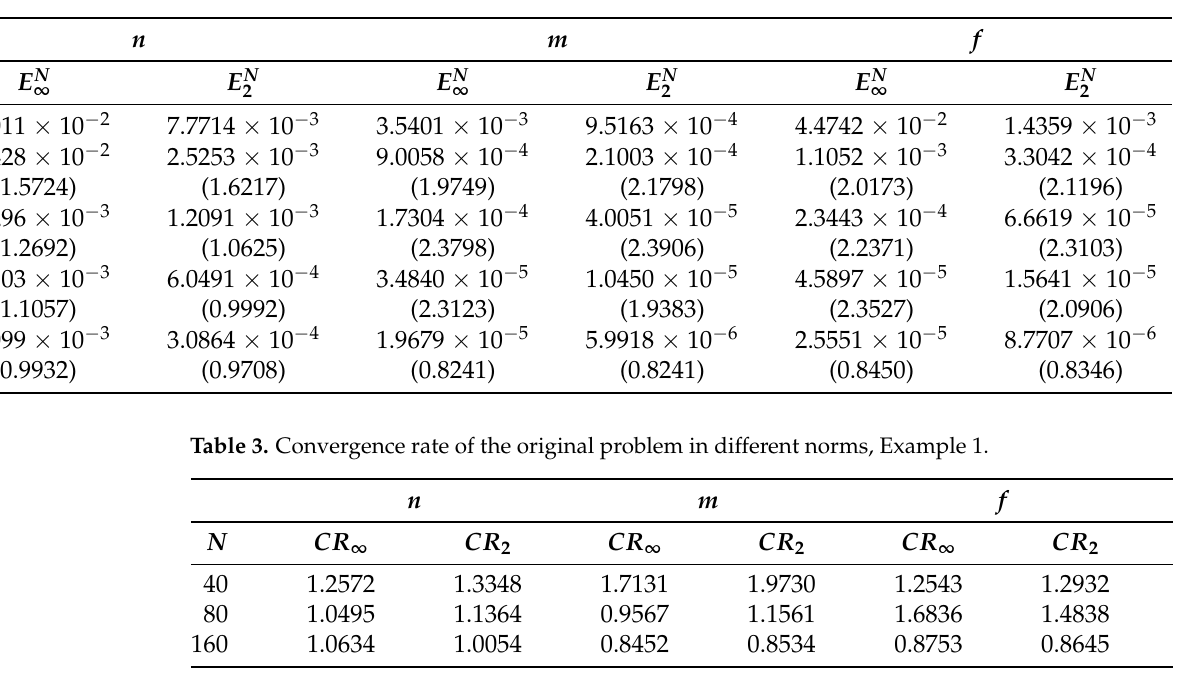
Table 2. Errors, convergence rates (bracketed) in different norms, Example 1.